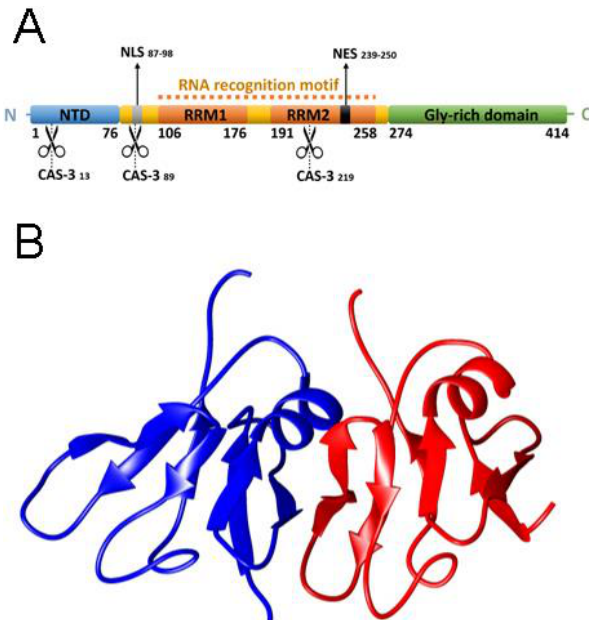
Figure 1. Gene architecture of TDP-43 ( A ) and structure of the NTD ( B ), spanning residues 1–80 (PDB code 6B1G) [13].